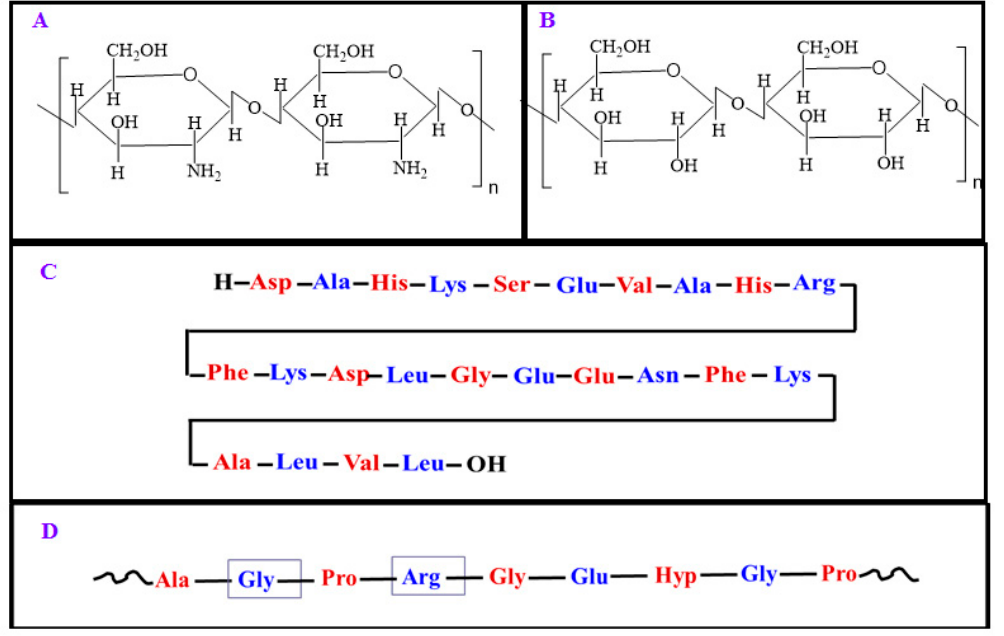
Figure 4. The chemical structures of the natural polymers, chitosan ( A ), cellulose ( B ), serum albumin ( C ), and gelatin ( D ).